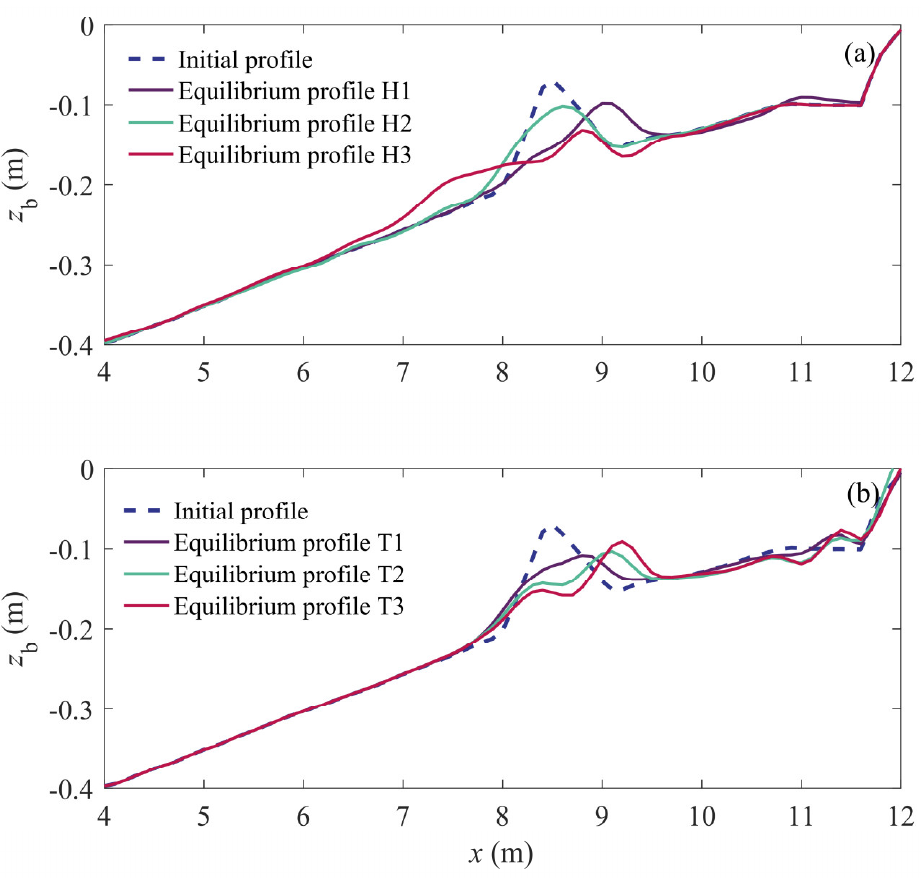
Figure 13. Equilibrium profile of the shoreface nourishment with different wave heights ( a ) and wave periods ( b ).